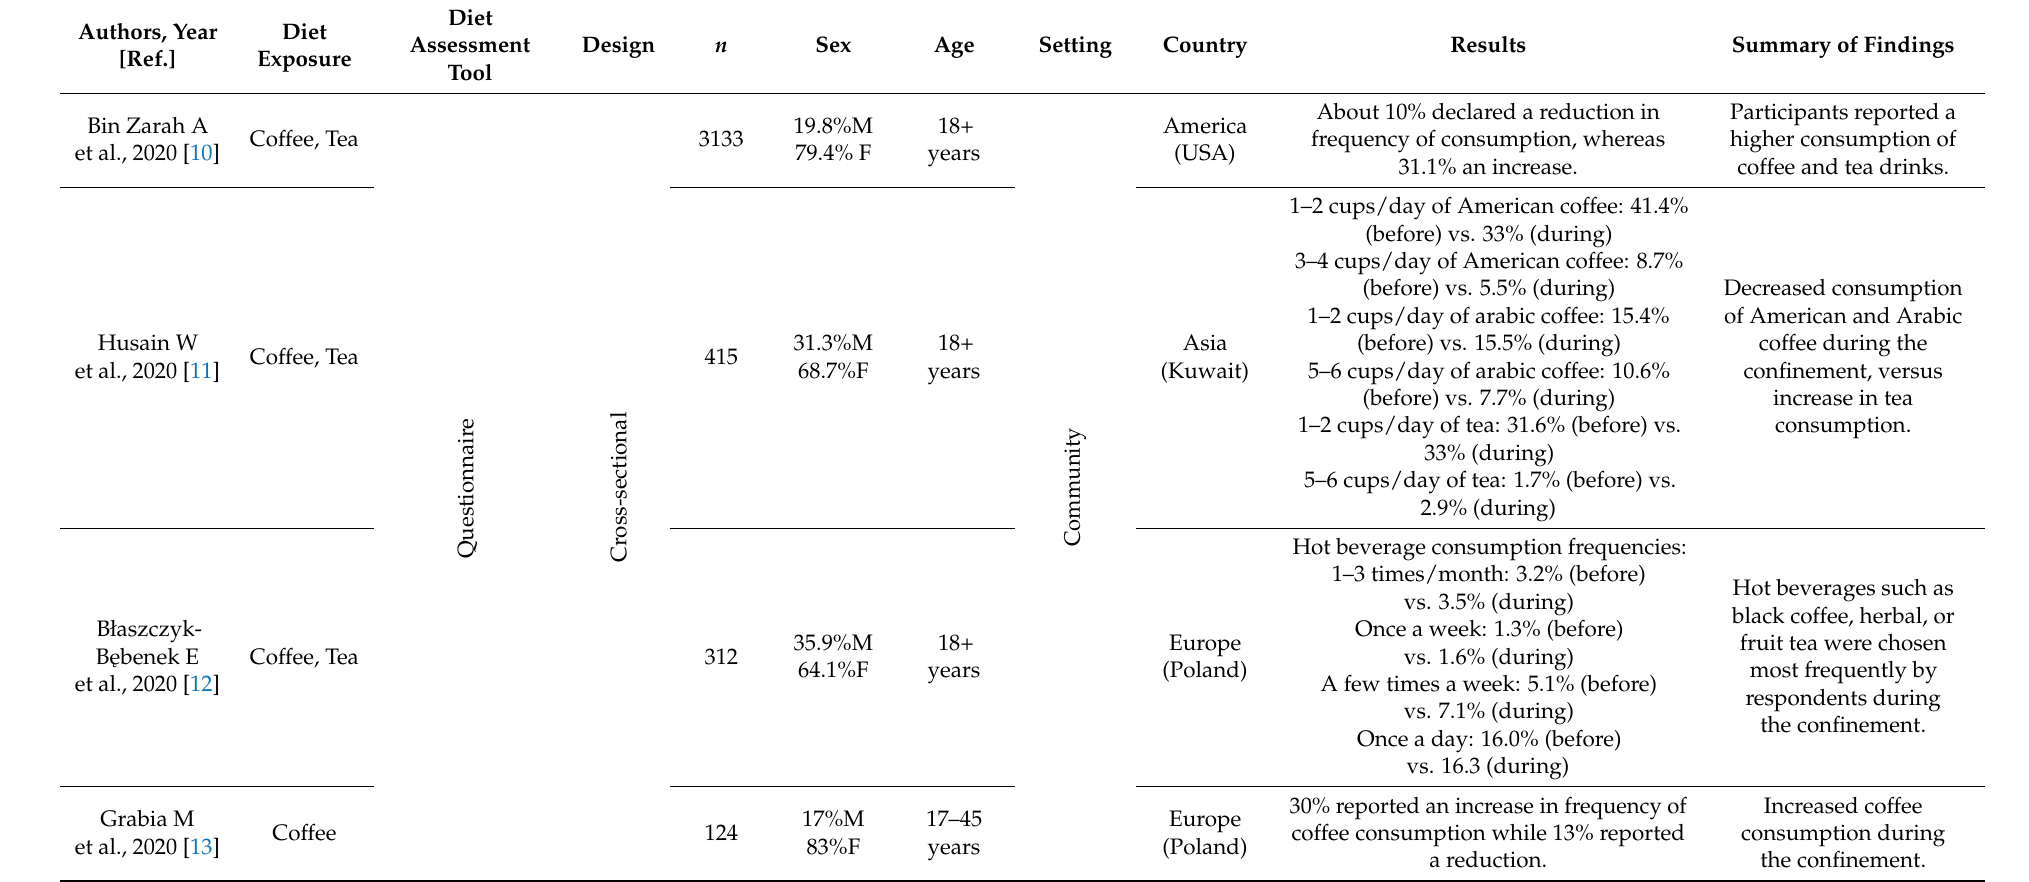
Table 2. Descriptive characteristics of included